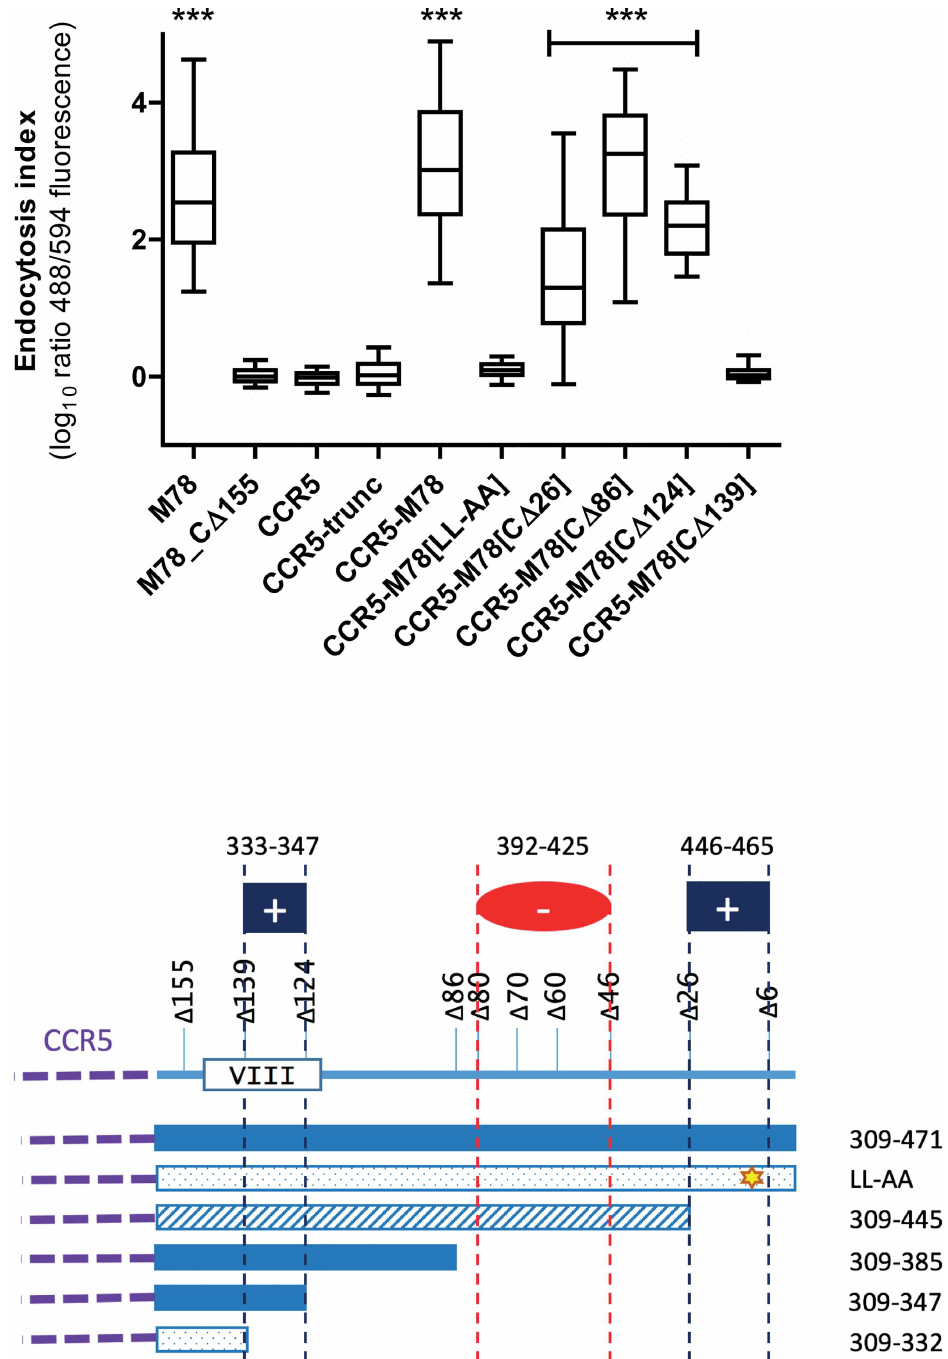
Fig 4. Endocytosis assay of CCR5/M78 chimeras. Hela cells were transfected with plasmids expressing HA-tagged CCR5, either wild type (CCR5), truncated to remove the C-tail (CCR5 trunc), or chimeric with the C-tail replaced by M78 C-tail sequenceseither wild type (CCR5-M78) or mutated (LL-AA, C Δ 26 –C Δ 139). HA-M78 and HA-M78_C Δ 155 were included as controls. One day post-transfection, cells were analysedfor endocytosis as describedfor Fig 3. Box and whiskers plots of the endocytosisindex (EI) are shown, with bars indicatingthe group medianand whiskers the 5 th and 95 th percentiles. Asterisks indicate statistical significance (Kruskal-Wallis, with Dunn’s post-test) comparingCCR5-trunc with the other constructs. ( *** P < 0.001). The various chimeric constructs and effects upon endocytosis are depicted schematically